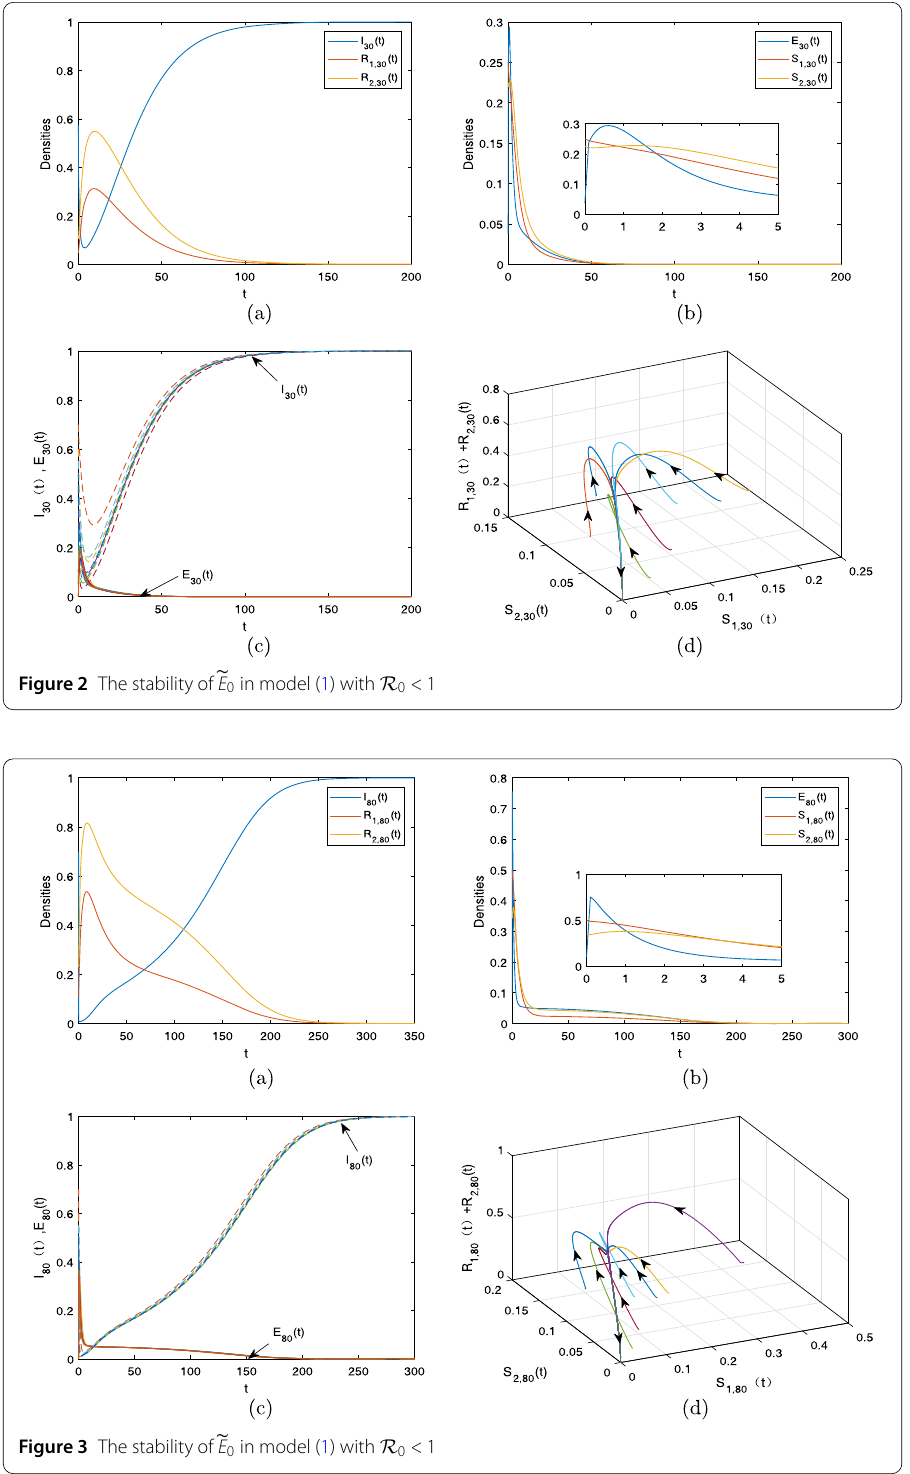
(cid:18) E 0 is ac-